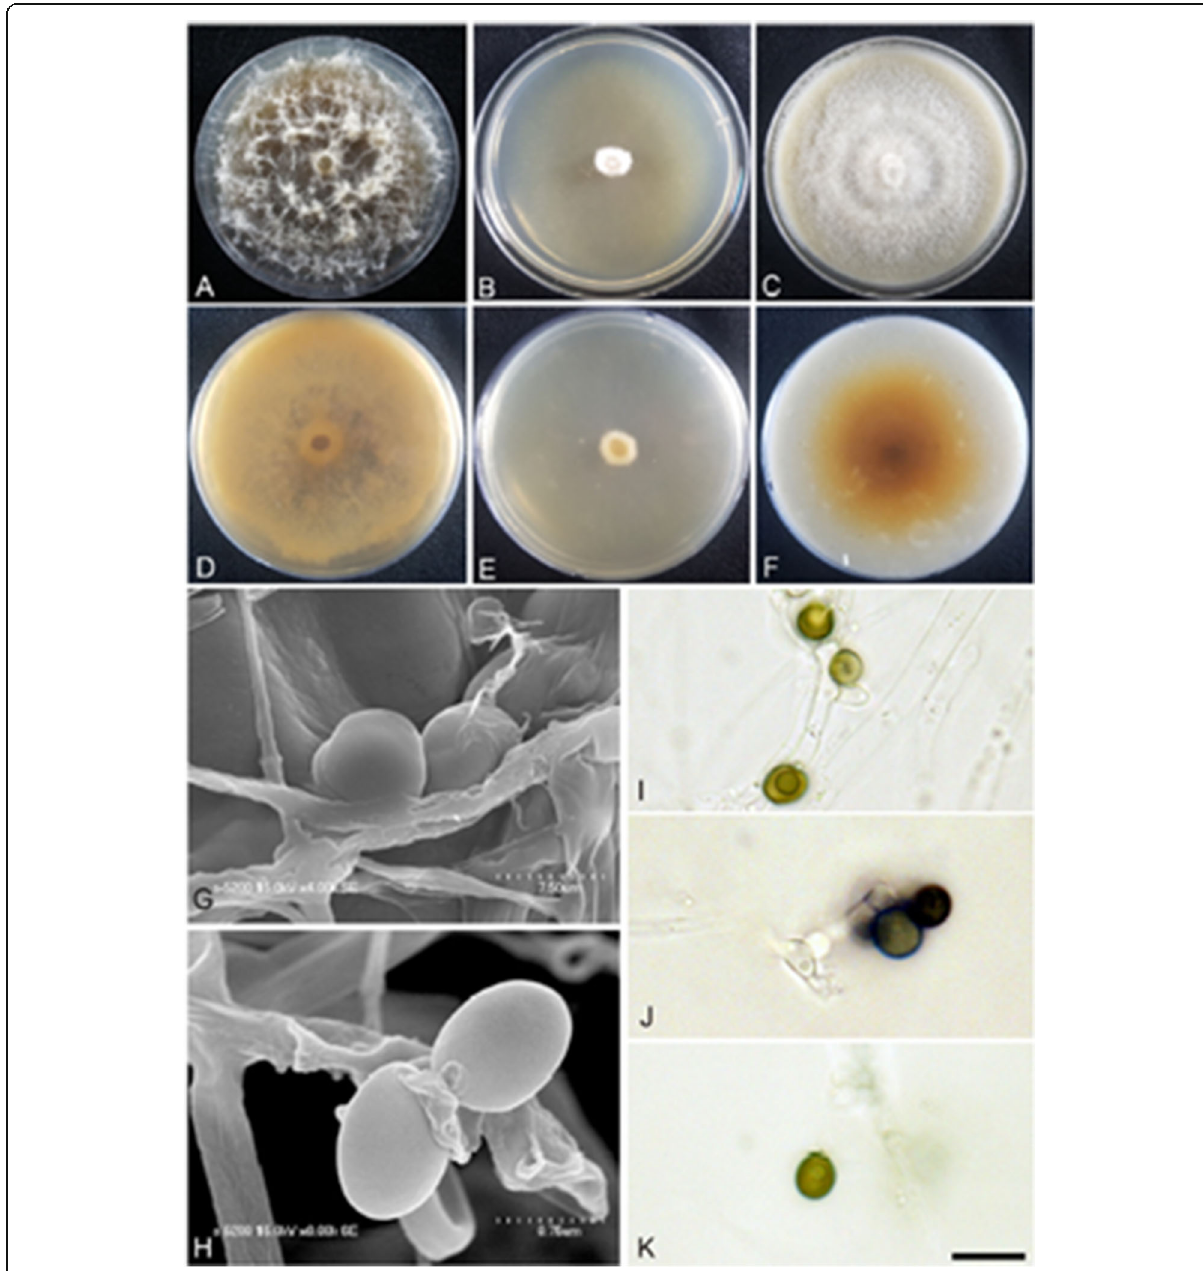
Fig. 6 Arthrinium koreanum (KUC21332). A-C, Colonies on PDA ( a ), MEA ( b ), and OA ( c) (top); d-f , colonies on PDA ( d ), MEA ( e ), and OA ( f ) (bottom); g-h , conidia under SEM; i-k , conidia attached to conidiogenous cells; scale bar=10 μ